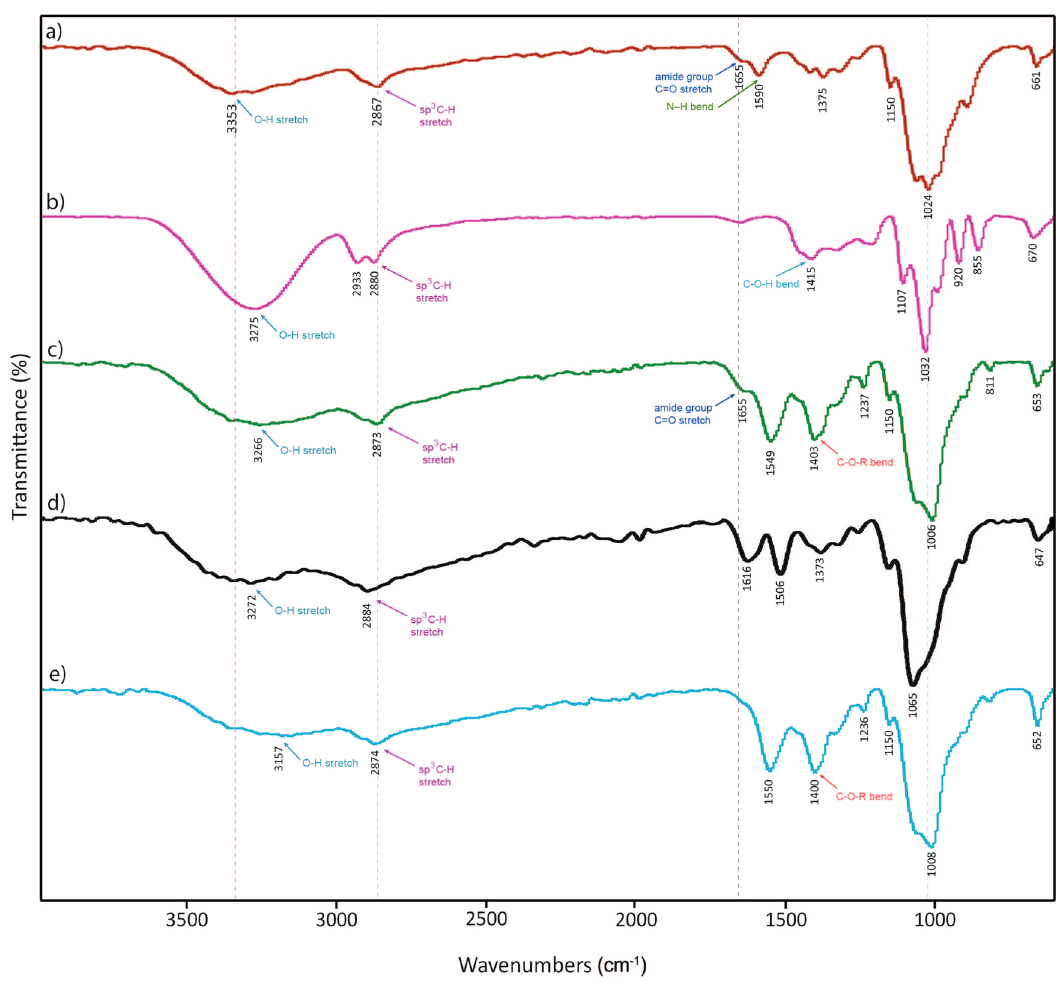
Fig. 3 FT-IR spectra of the synthesized hydrogels. a Chitosan, ( b ) Glycerol, ( c ) CS-g-gly, ( d ) CMCS, ( e )